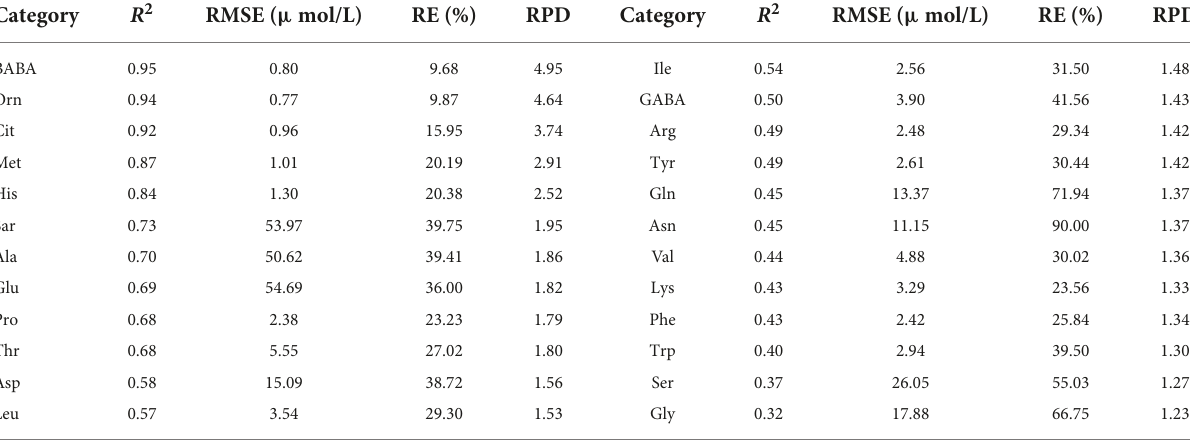
TABLE 2 Evaluation results of PLSR model using test set for various amino acid contents based on the reflectance of all